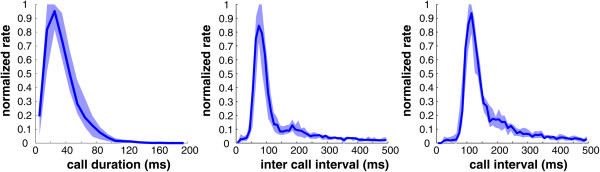
Distribution of median call duration, inter-call interval, and call interval normalized for 18 mice. Bin width 10 ms, shaded areas indicate 1st and 3rd quartiles.